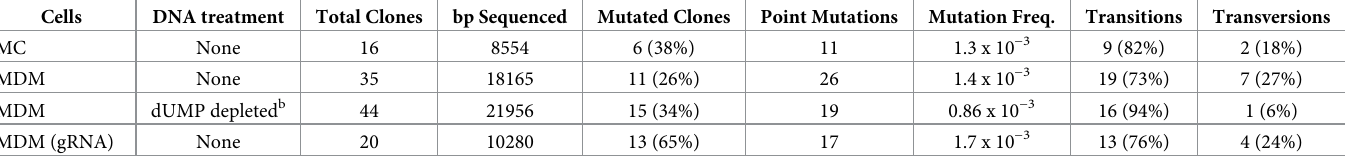
Table 1. Mutational analysis of HIV proviral DNA and extra cellular viral RNA extracted from infected MC and MDM a . Cells DNA